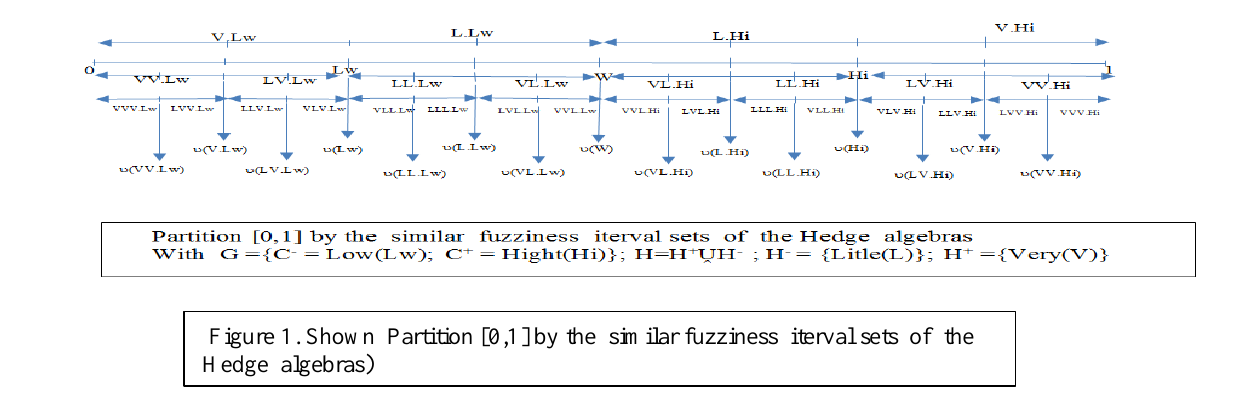
Figure 1. Shown Partition [0,1] by the similar fuzziness iterval sets of the Hedge algebras)